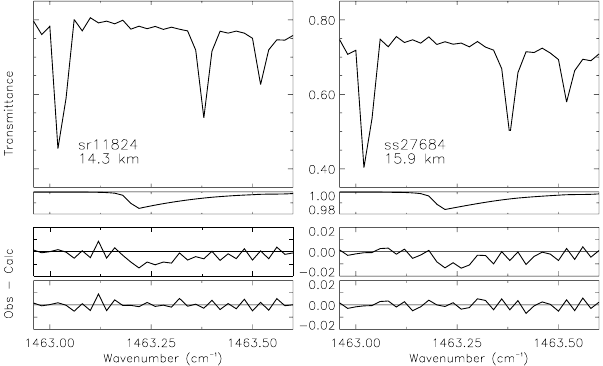
Fig. 1. The retrieval microwindows for ACE-FTS occultations sr11824 and ss27684. The top panels show the transmittance spec- tra at tangent heights of 14.3 and 15.9km, respectively. The sec- ond panels reveal the calculated contribution to each measurement based on the retrieved VMR ( < 2%). The third panels give the observed–calculated residuals for both retrievals without the inclu- sion of acetonitrile in the forward model. The bottom panels contain the observed–calculated